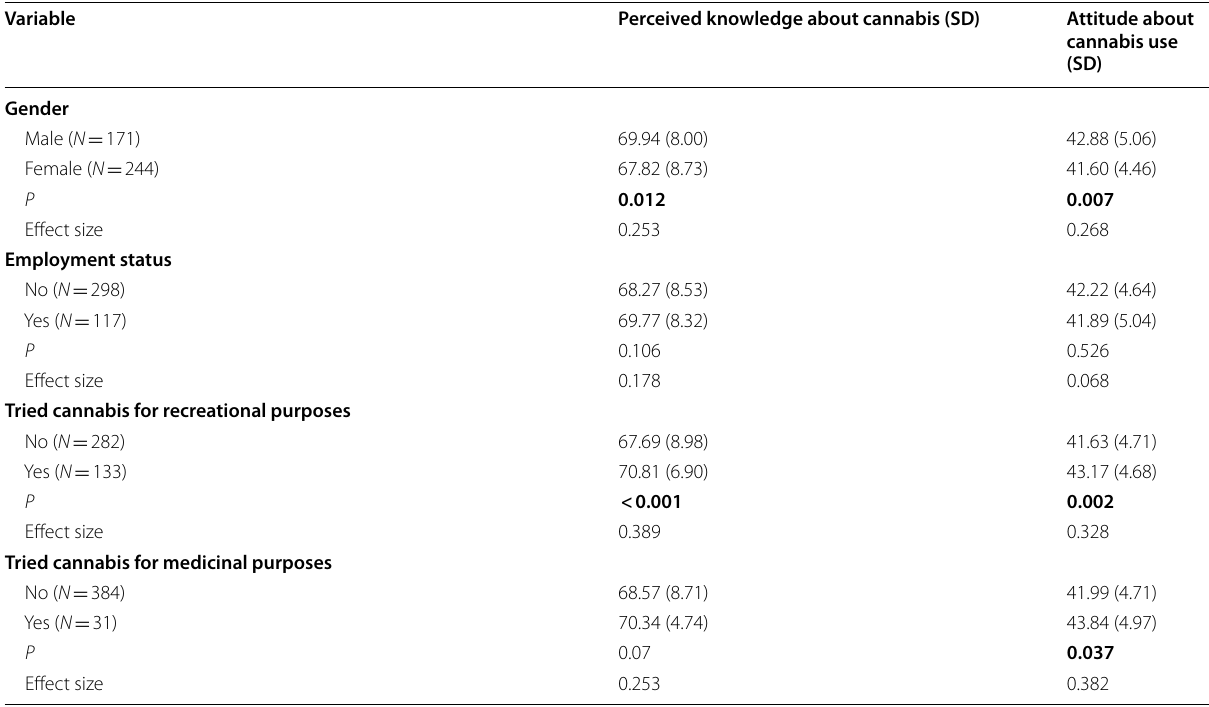
Numbers in bold indicate significant p -values; Student t test was used to compare 2 means. Effect size refers to Cohen’s d value